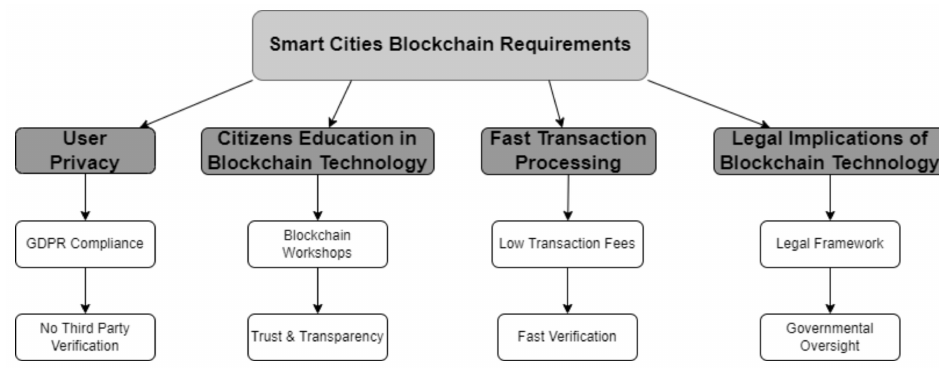
Figure 5. The requirements of blockchain